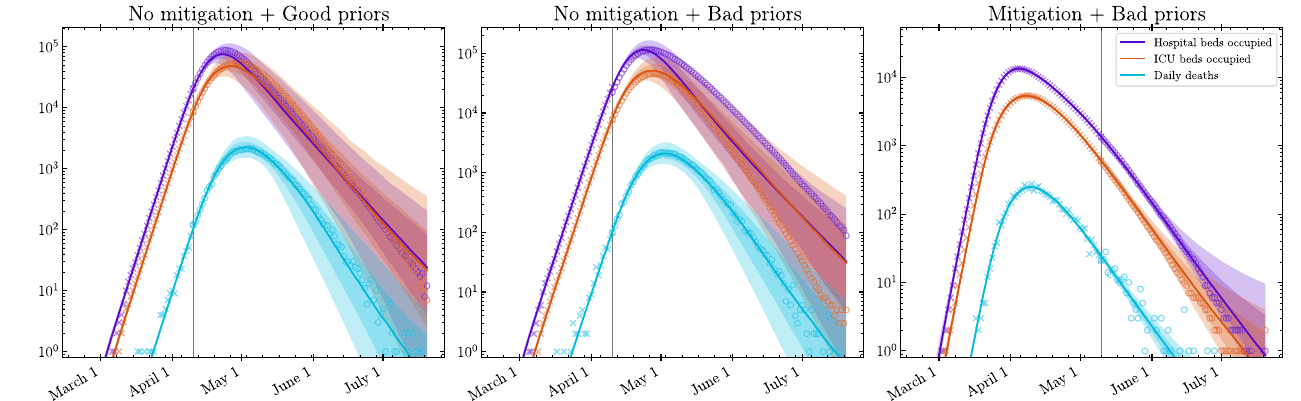
constrained.FIG. 12. Comparison of synthetic (generated) epidemic trajectories against calibration prediction for hospital beds occupied, ICU beds occupied, and daily deaths. Only data up to the vertical line (x markers) are used during the calibration procedure. The forecast for the downward part of the trajectories is heavily influenced by the removal timescales, which exhibit a low signal in the initial exponential phase, so the quality of the forecast for the “ No Mitigation ” scenarios is influenced by the quality of the prior. In the “ Good (Bad) Prior ” scenario, the removal timescales are chosen to be consistent (inconsistent) with the prior. Increasing the amount of data fed to the calibration procedure (as in the “ Mitigation ” scenario) allows the sampler to better infer the removal